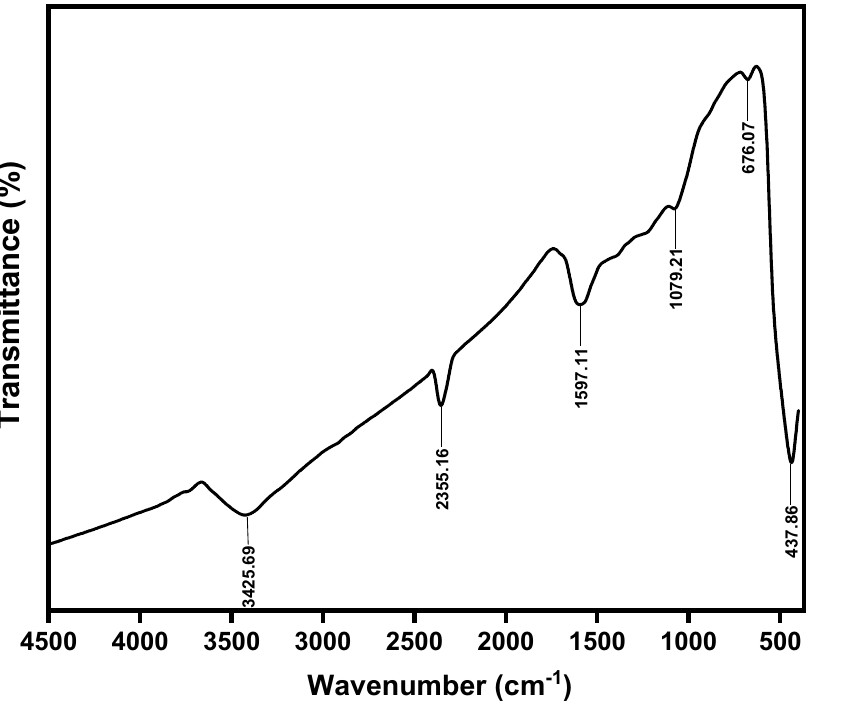
Figure 5. FTIR spectra of the synthesized (Z3C1)